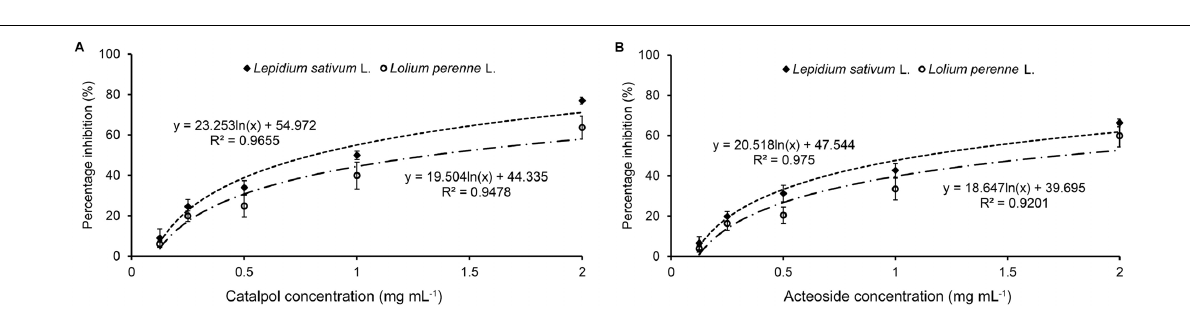
FIGURE 6 | Petri dish-filter paper phytotoxicity assay of catalpol (A) and acteoside (B) on L. sativum (dicotyledon) and L. perenne